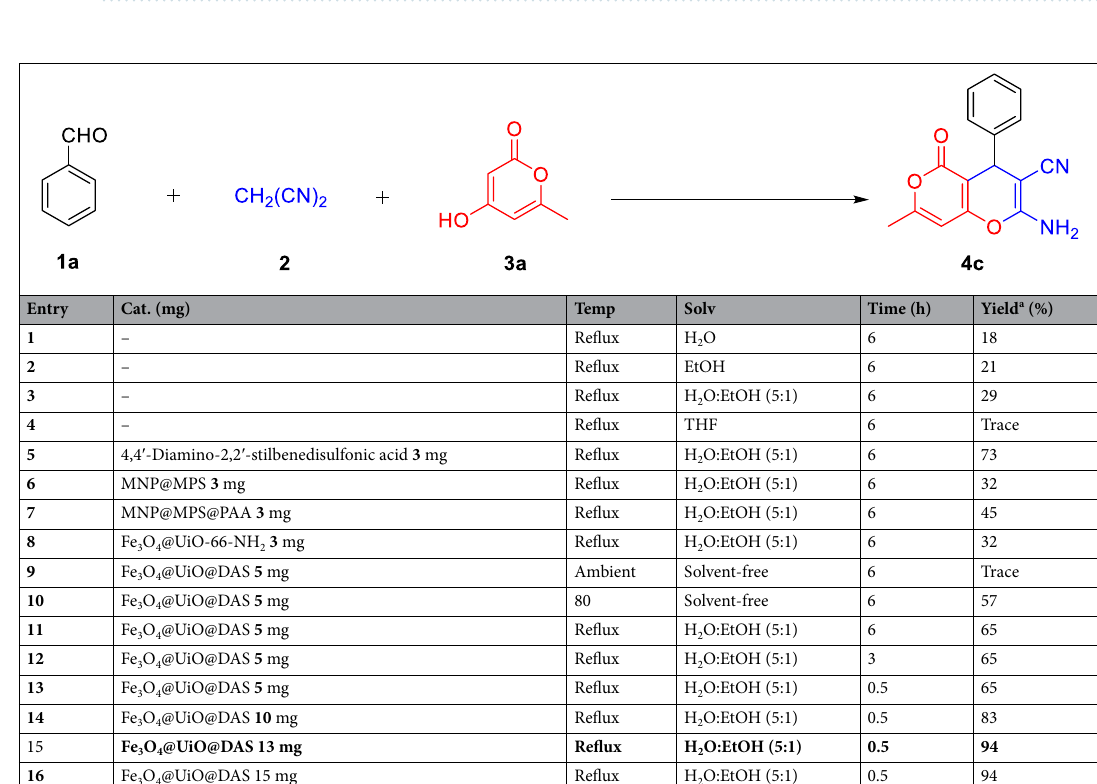
Table 1. N 2 adsorption–desorption data.